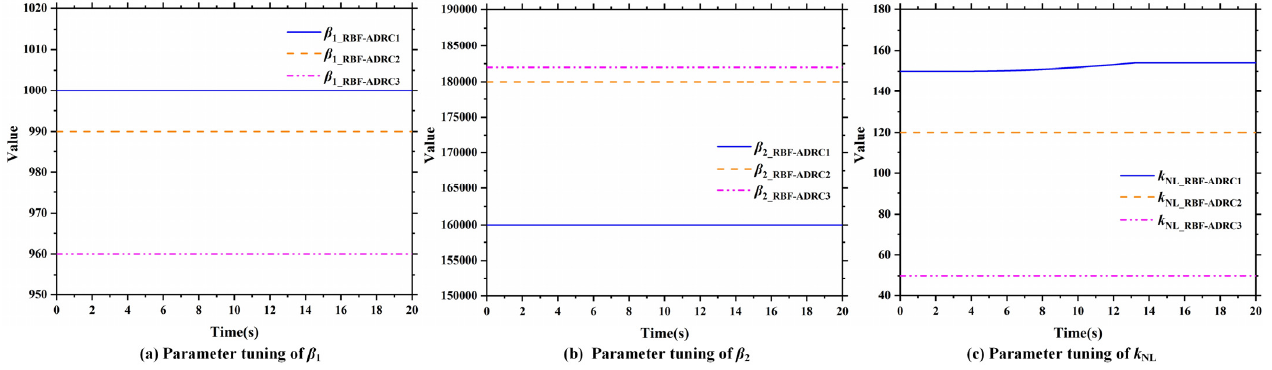
Figure 13. The ESO and NLSEF parameter adjustment curves under tension disturbance(150 m/min).